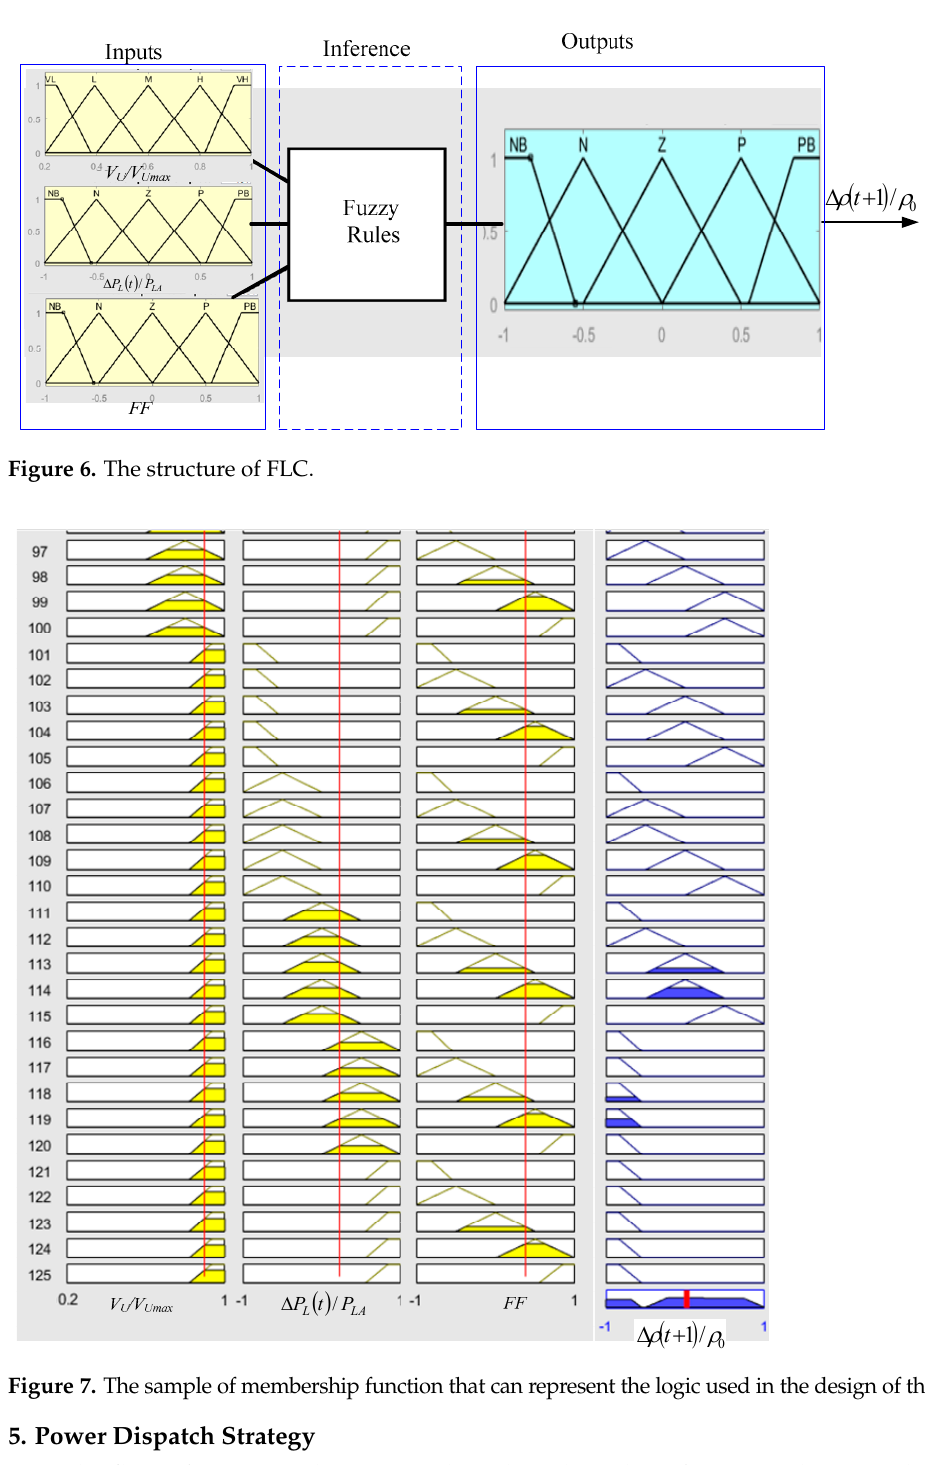
Figure 5. The block diagram of the demand response strategy with FLC.